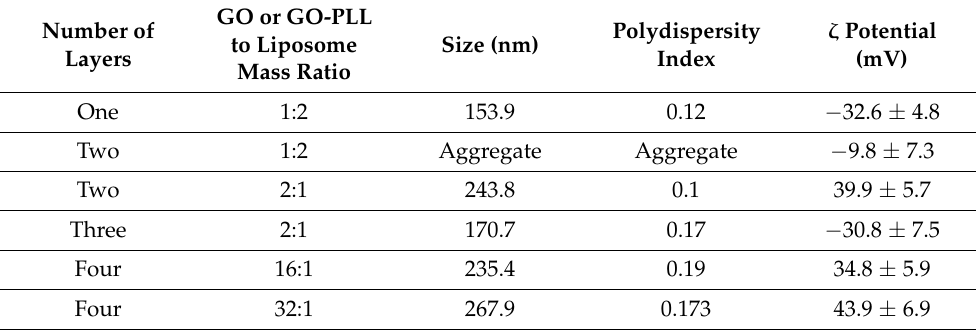
Table 2. Optimization of graphene oxide or graphene oxide-poly (L-lysine) layer by layer liposome system